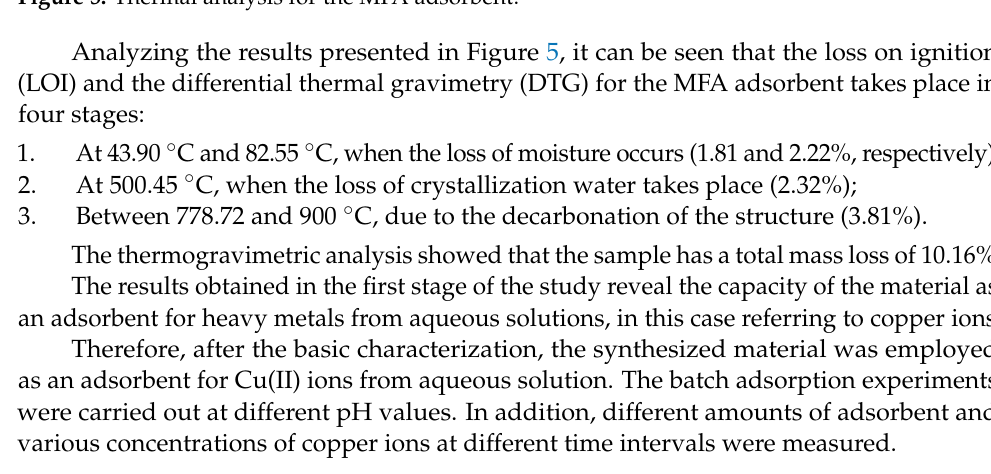
Figure 5. Thermal analysis for the MFA adsorbent.